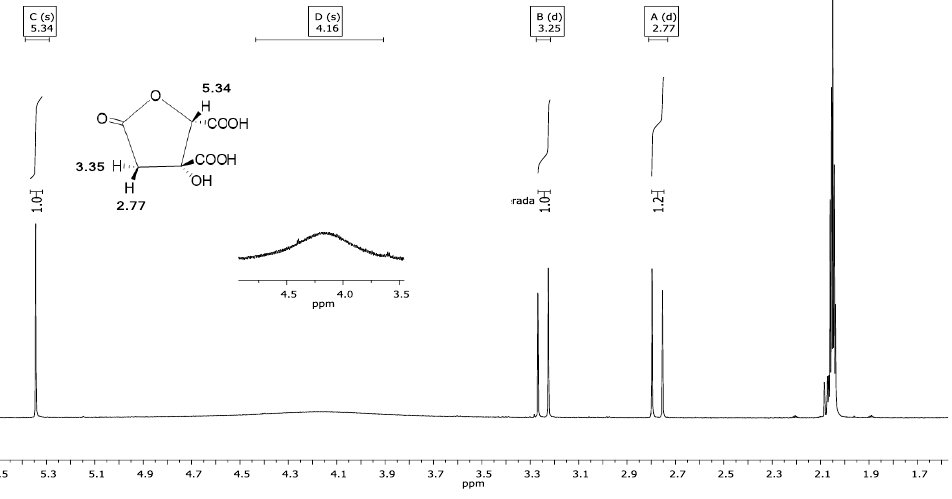
Figure 1. 1 H NMR spectrum at 400 MHz in acetone- d 6 of purified crystals obtained from Hibiscus sabdariffa calyces acetonic extract.